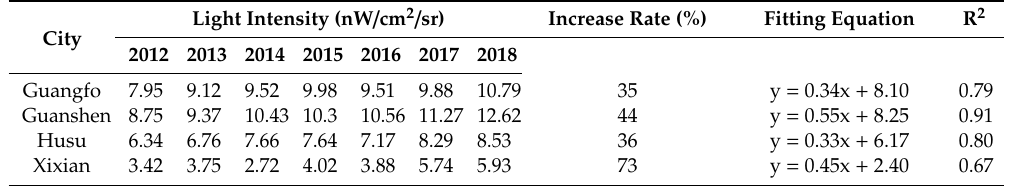
Table 3. The light intensity fluctuation and its linear regression of boundary